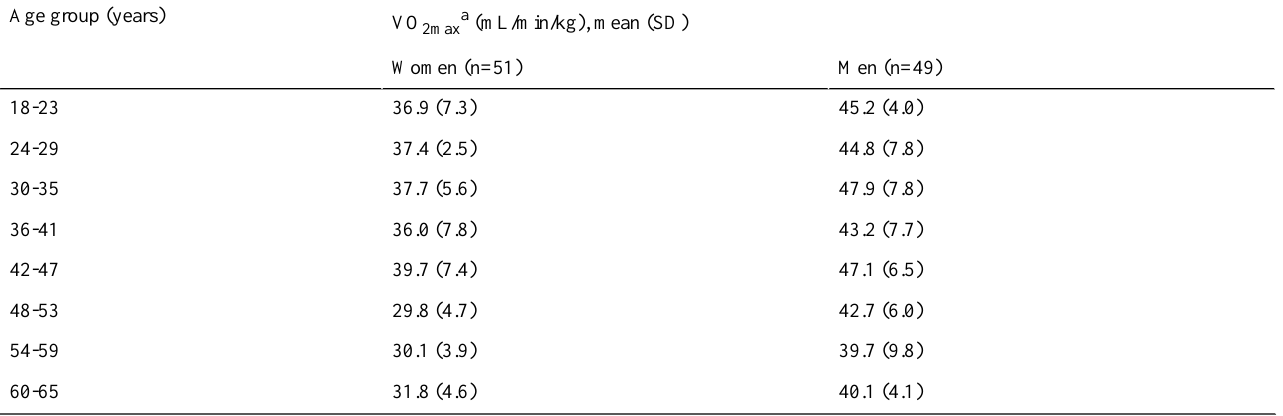
Table 2. Maximal oxygen consumption of study participants in the derivation cohort.